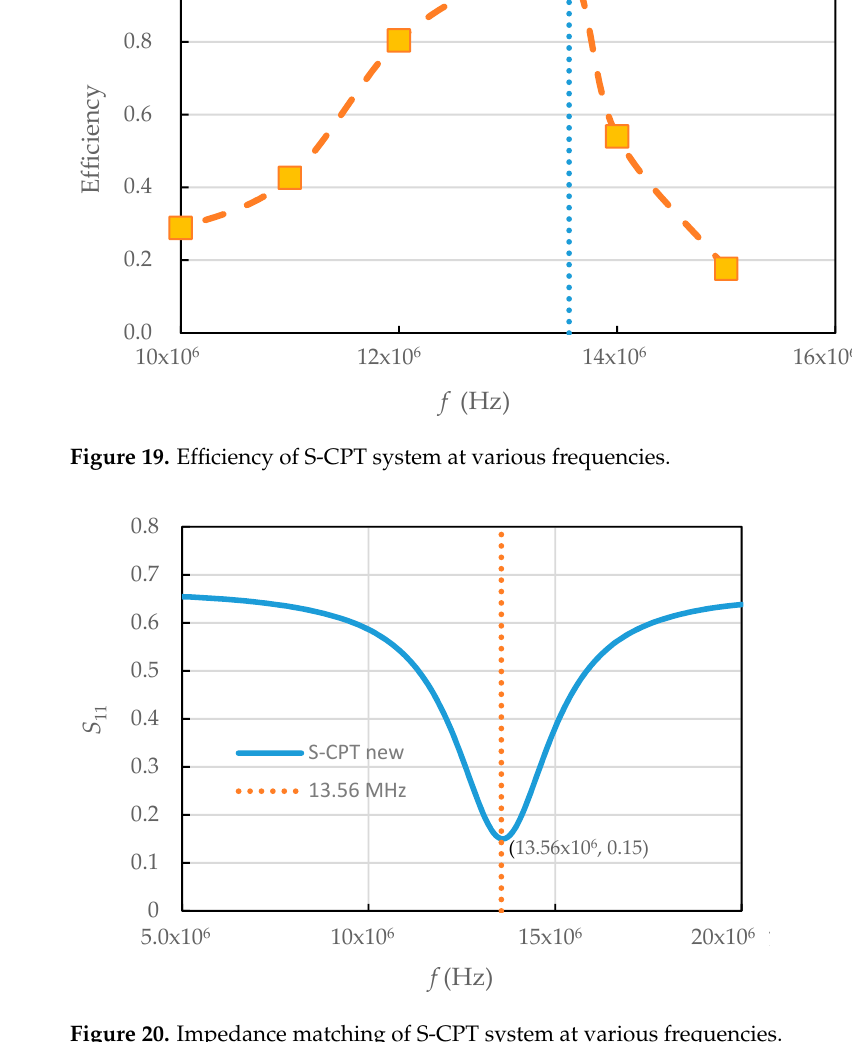
Figure 20. Impedance matching of S-CPT system at various frequencies.